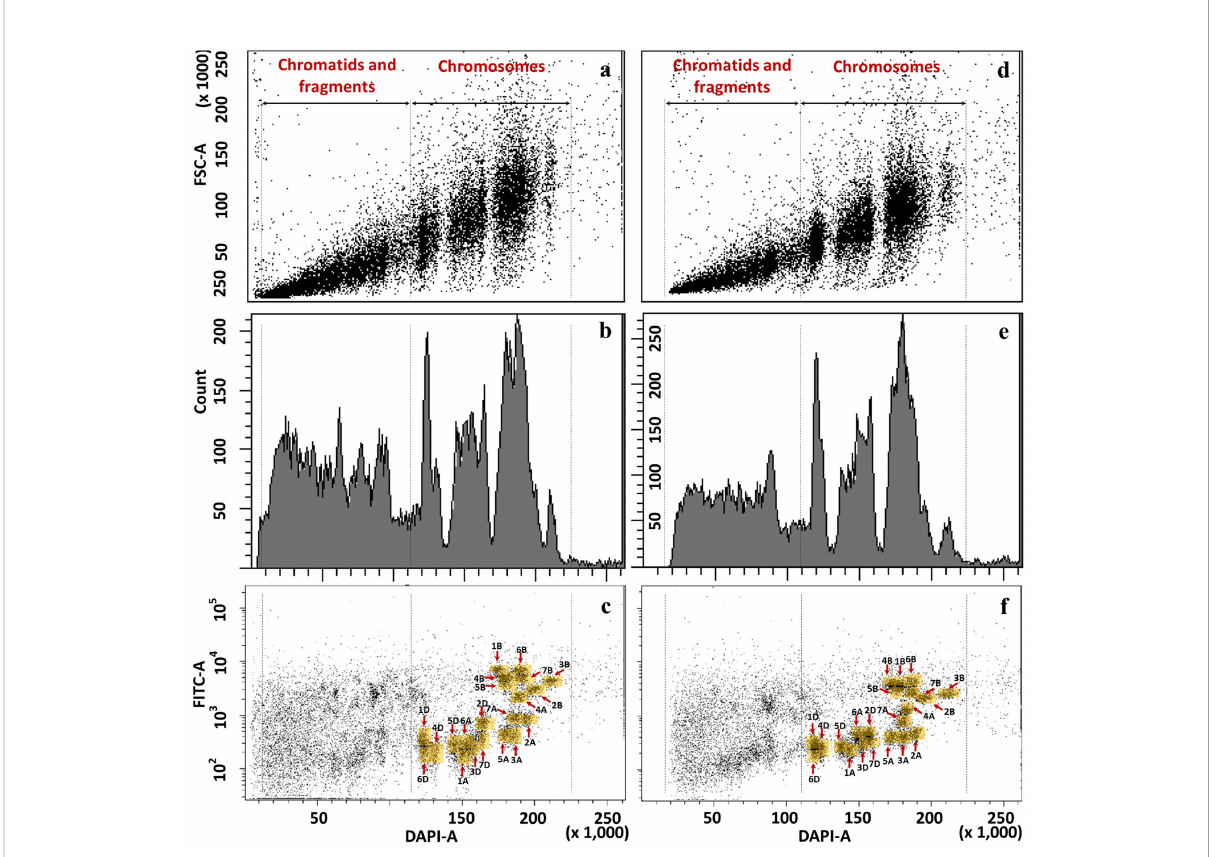
FIGURE 5 Flow cytometric analysis and sorting in hexaploid wheat cv. Mv9kr1 (A – C) and cv. CS (D – F) chromosomes. (A, D) . bivariate fl ow karyotypes DAPI (x-axis) vs. FSC (y-axis), (B, E) monovariate fl ow karyotypes DAPI (x-axis) showing count (y-axis), (C, F) bivariate fl ow karyotypes DAPI (x-axis) vs. FITC (y-axis) obtained after FISHIS with (GAA) 7 on chromosomes isolated from wheat Mv9kr1 (C) and wheat CS (F) . The analysis permitted discrimination of the 21 chromosome pairs (yellow boxes) of hexaploid